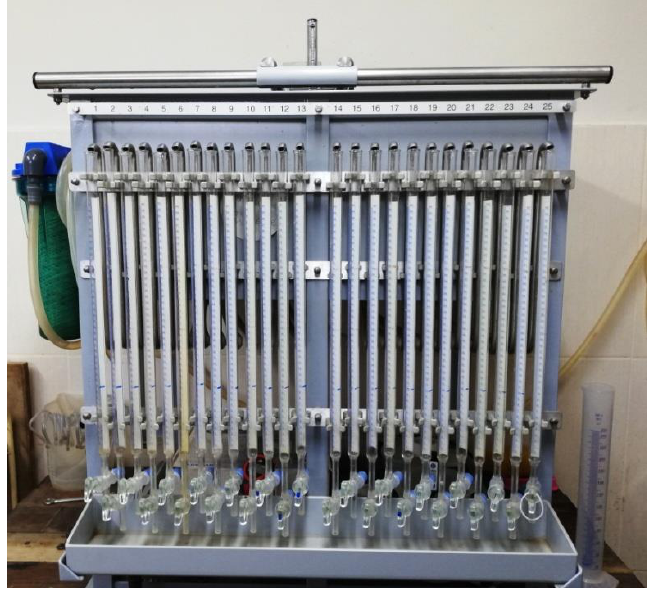
Figure 3. The laboratory permeameter produced by the Eijkelkamp (photo. Ł. Borek).